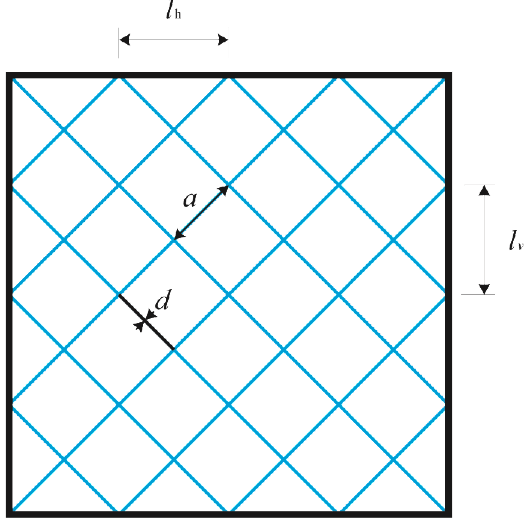
Figure 13. Description of solidity and hanging ratio of net panel.